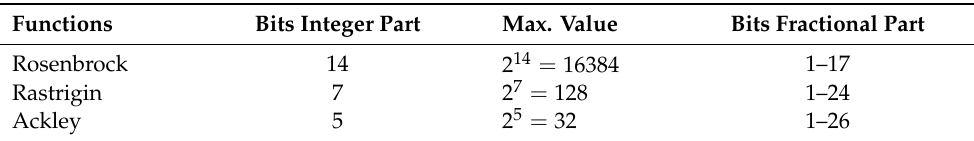
Table 3. Calculation of the number of bits in the integer part for the simulations using fixed point arithmetic. Numbers shown here must be greater than the corresponding ones in Table 2 to permit the optimization operations for differential evolution (DE).